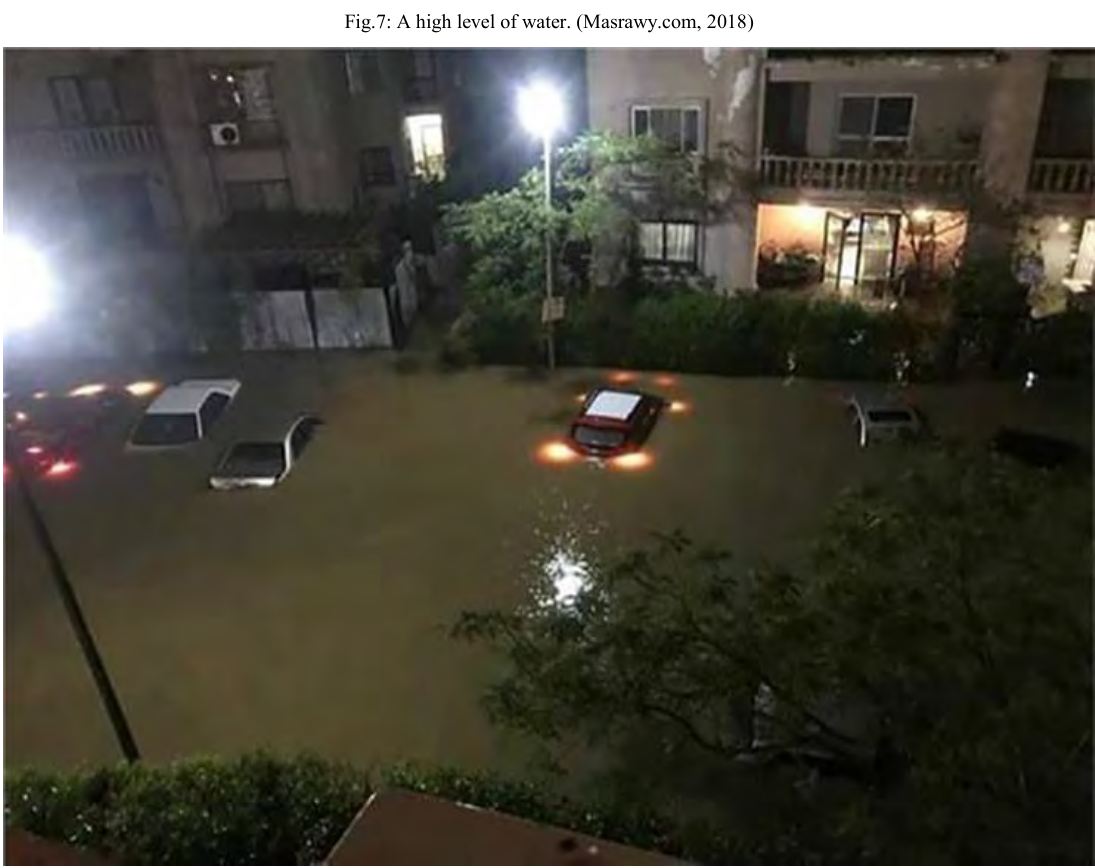
Fig.8: Sinking cars and homes. (Masrawy.com,